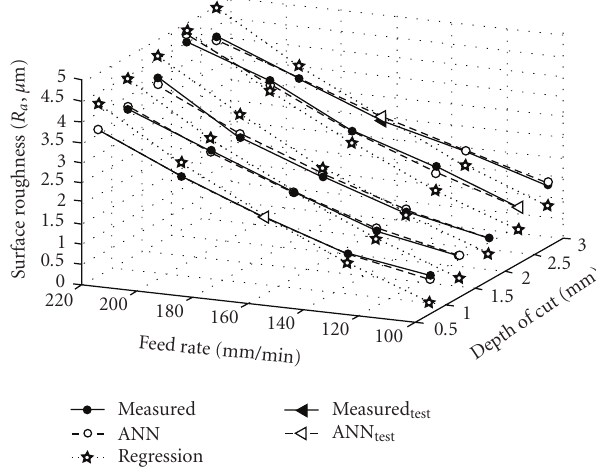
Figure 14: The residual surface roughness versus predicted surface roughness of ANN model.